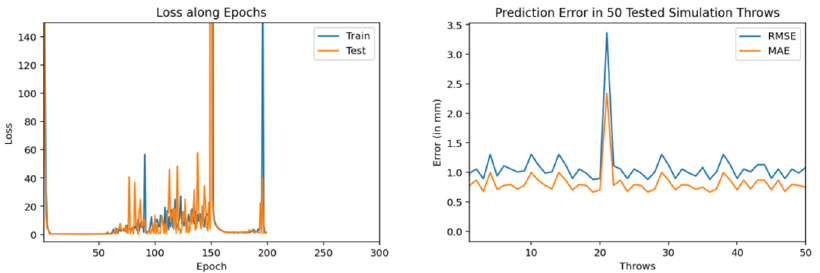
Figure 12. Training and testing results by encoder-decoder bidirectional LSTM deep NN. (trained through 1000 throws with 200 epochs and 100 neurons) .